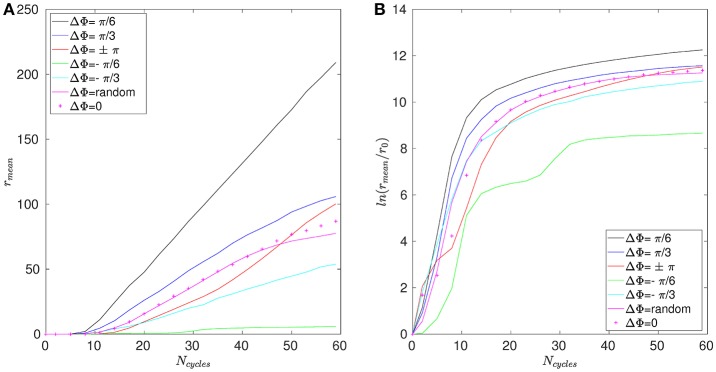
Results obtained for position A and Re = 5.10−2. (A) Average distance rmean between the fathers and the children as a function of the number of cycles Ncycles. (B) Logarithm of the dimensionless average distance rmean/r0 as a function of the number of cycles Ncycles.